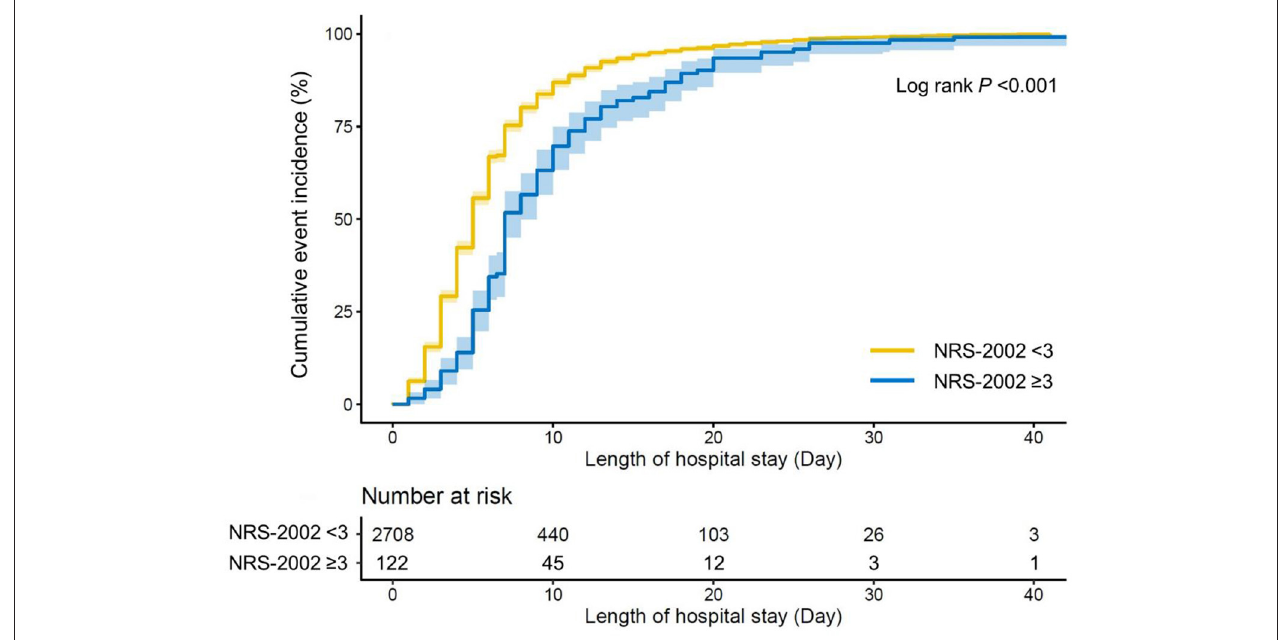
FIGURE 3 | Cumulative incidence of discharge stratified by nutritional status. Kaplan–Meier curve was plotted to show the cumulative incidence of discharge in patients with low nutritional risk and high nutritional risk. Log rank p -value was also shown. NRS-2002 indicates Nutritional Risk Screening 2002.